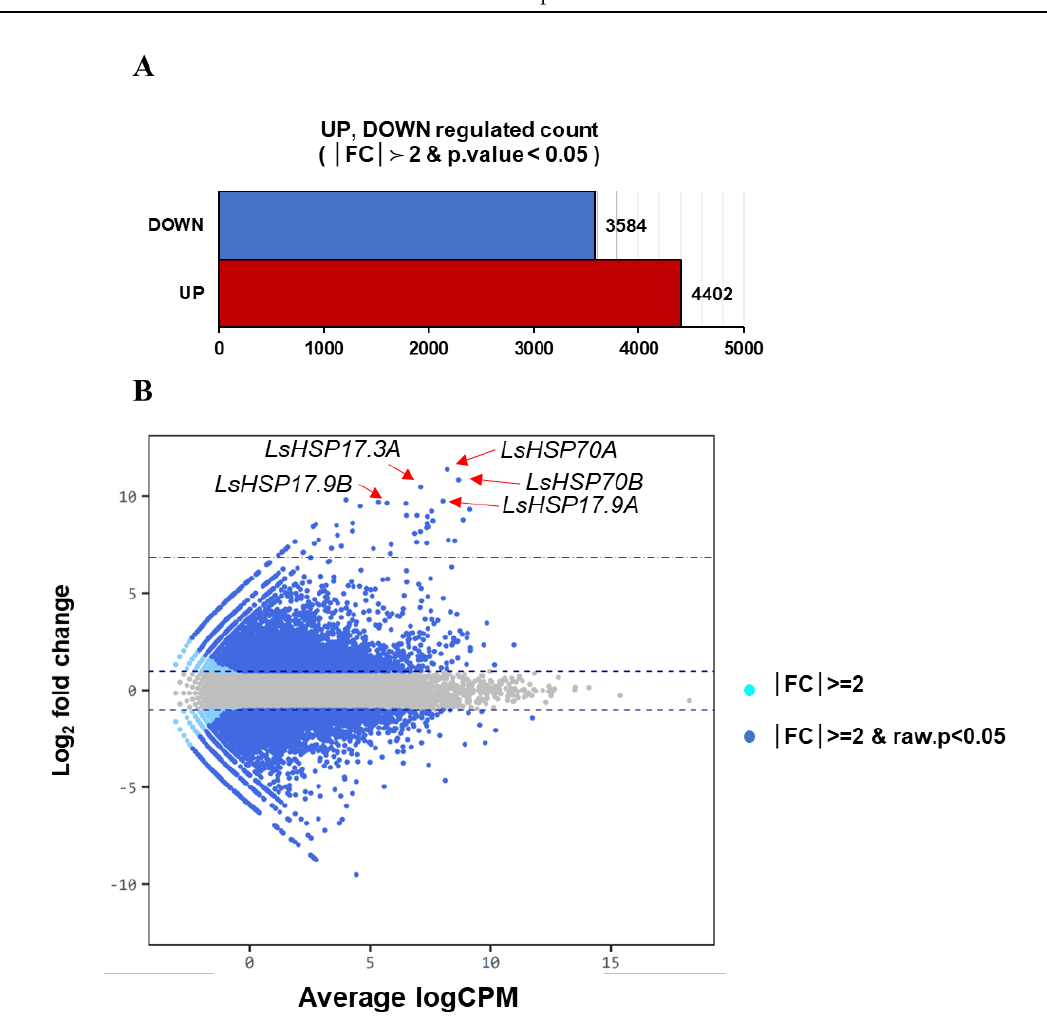
Figure 2. Transcriptome profiling of gene expression dynamics in lettuce with heat treatment. ( A ) Number of differentially expressed genes (DEGs) in lettuce with heat treatment (37 °C) compared to those with optimal temperature (20 °C) for 1 h. ( B ) The EdgeR smear plot shows the Log 2 fold change (FC, y -axis) against the average log count per million (CPM, x -axis). The dashed red line shows the location of the value of FC = 100. Points above the line have FC > 100 and those below the line have FC < 100 values. The red arrows indicate the top five LsHSP genes displaying both a large magnitude of FC and high expression volume. The two dashed blue lines represent two-fold changes. This plot is colored such that those points having a fold-change less than │ FC │ < 2 are shown in gray, │ FC │ ≥ 2 in pale blue, and │ FC │ ≥ 2, raw. p -value < 0.05 in dark blue.